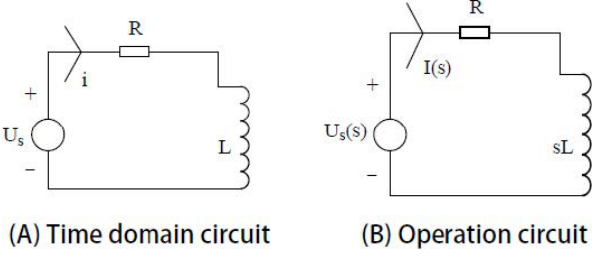
Fig. 4 RL series circuit.